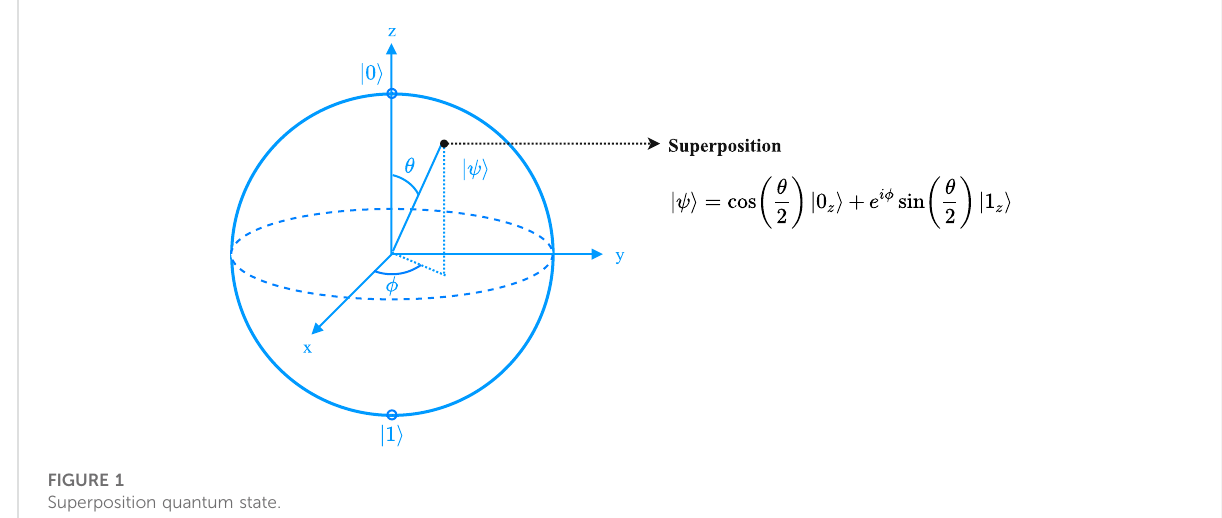
FIGURE 1 Superposition quantum